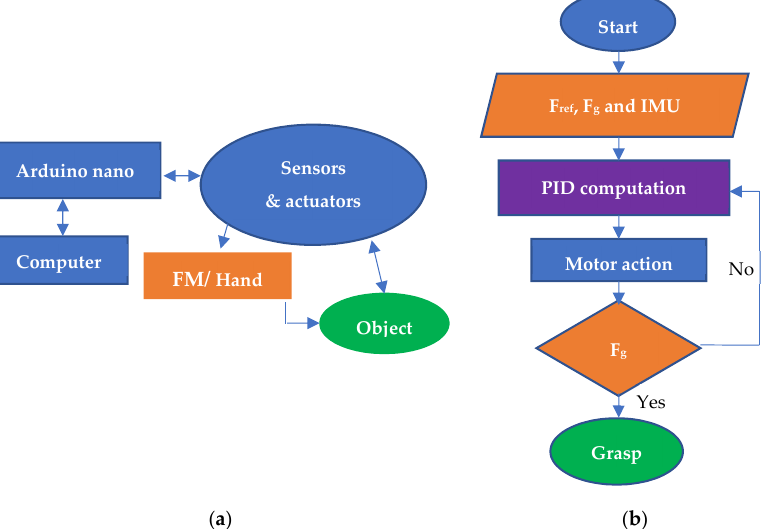
Figure 3. Interaction and conceptual layouts: ( a ) Scheme of interaction between ExoFinger and an object to grasp (FM indicates the Finger Mechanism), ( b ). A conceptual scheme for control action, where F ref represents the reference (desired) force and F g is the payload acting on the system.